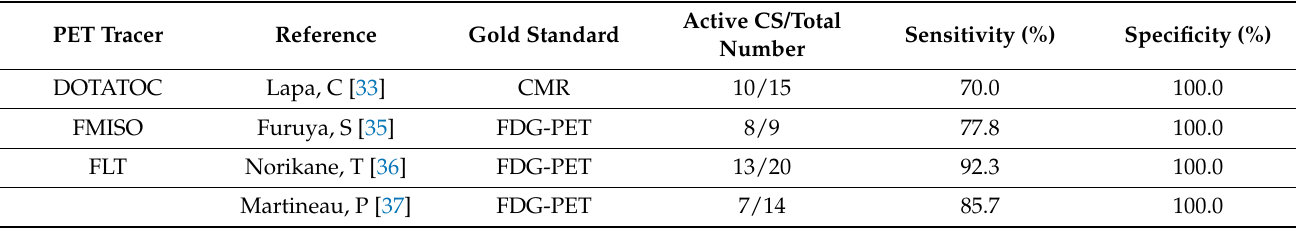
Table 5. Diagnostic ability of the other tracers of PET.